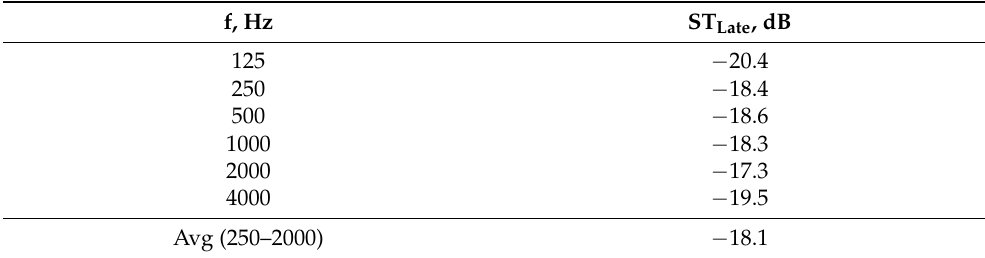
Table 12. Late support, ST Late